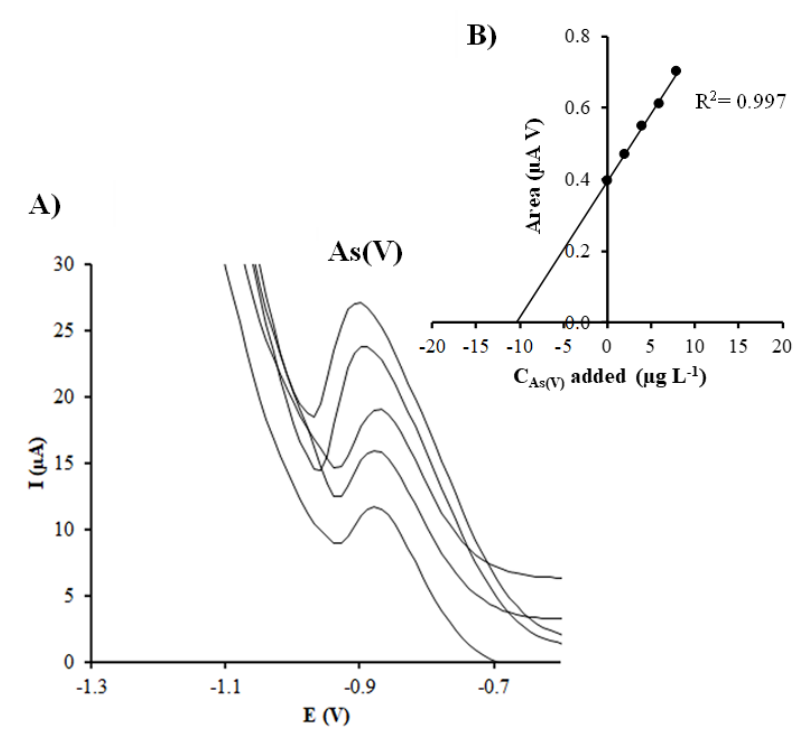
Figure 5. ( A ) DPASV measurements of As(V) in a spiked tap water sample on Ag-NS-SPCNFE at pH 2.0 applying an E d of -1.30 V and a t d of 120 s; and ( B ) As(V) standard addition plot.